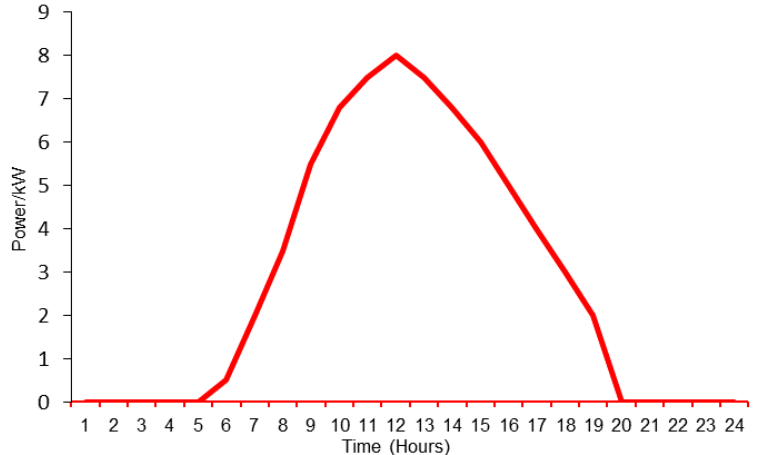
Figure 5. ( a , b ). Load profiles of VPP1 and VPP2.